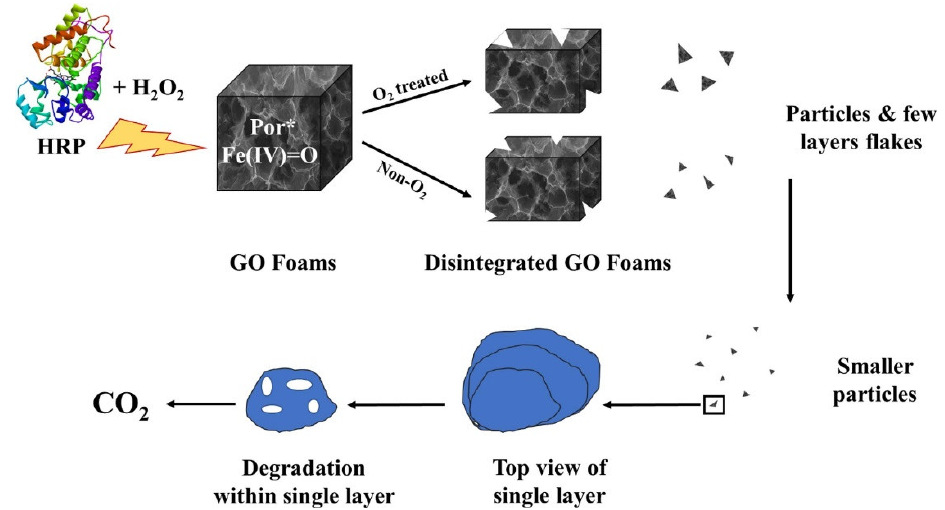
Figure 2. Biodegradation of cisplatin-loaded graphene foams as reported by Ezzati et al. [96] .